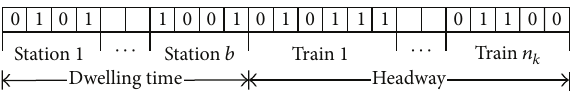
Figure 4: The expression of